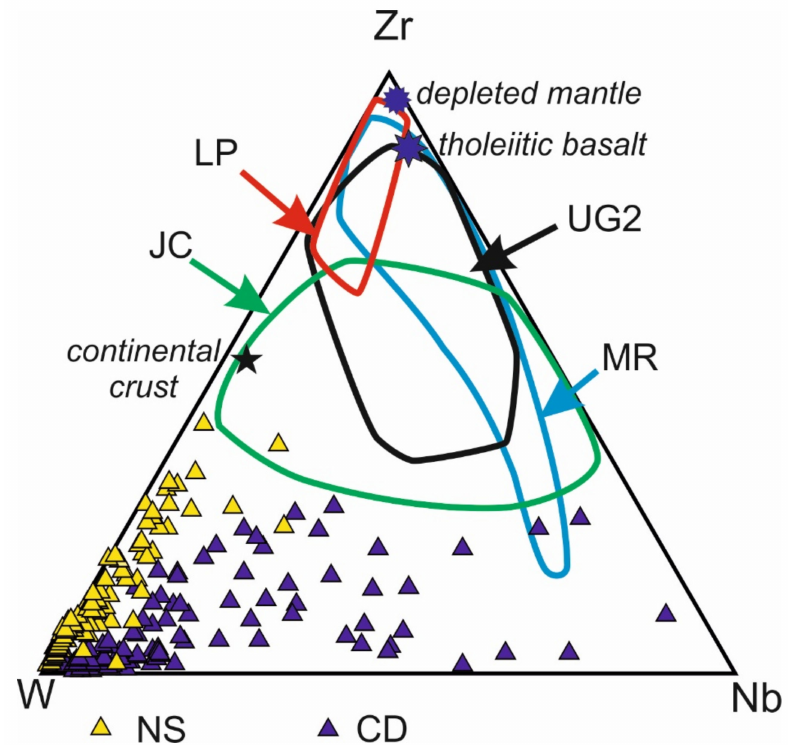
Figure 14. Compositional fields and data point distribution of HFS (Nb-Zr-W) in rutile from the different types of chromitite. Contour color: Red = Loma Peguera (LP), Black = UG2, Blue-Sky = Merensky Reef (MR), Green = Jacurici (JC). Yellow Triangle = Nuasahi. Blue Triangle = Cedrolina. Blue Stars = estimated average composition of depleted mantle, tholeiitic basalt, and continental crust taken from a wide